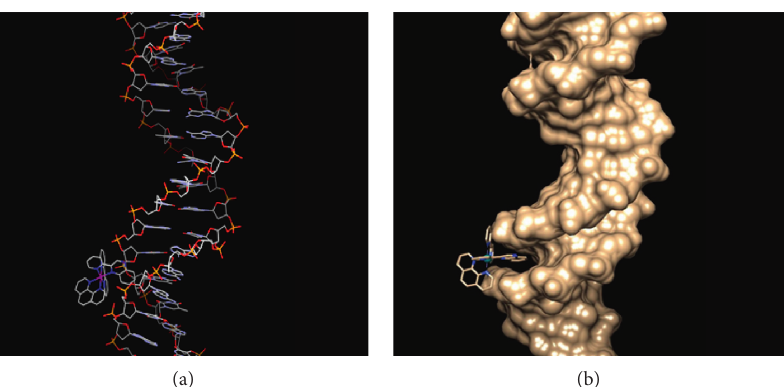
Figure 11: (a) Visualization of the interaction of 2 via 2, 2’-pq moiety to the specific region of the sequence of DNA (5D2Q). (b) Interaction of complex 2 through the 2, 2’-pq moiety with the hydrophobic DNA sequence (PDB: 5D2Q).